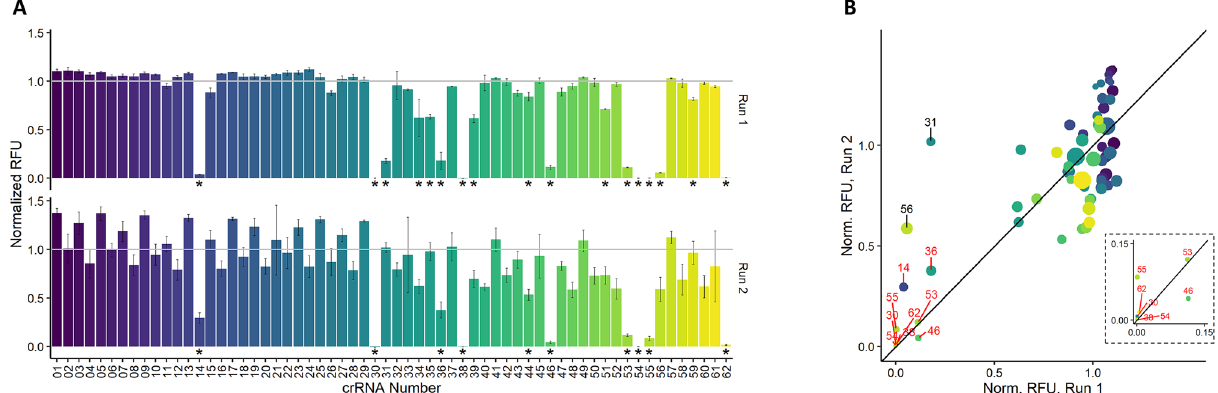
Figure 4. ( A ) Comparison of Cas13a activity from crRNAs from set 0056 prepared in batch on different days, shown as sums of fluorescence values normalized to internal control. Bars represent mean and error bars show standard deviation (n = 3), and p -values < 0.05 as determined by analysis of variance and Tukey test against the internal control are denoted by *. ( B ) Comparison of normalized sums of RFU from each crRNA preparation, where values represent mean, dot size represents relative standard deviation, red labels represent crRNAs that produce Cas13a activity significantly different from internal control with p -value < 0.05 in both runs, and black labels represent crRNAs where Cas13a activation improved to within 50% of the internal control after repeated